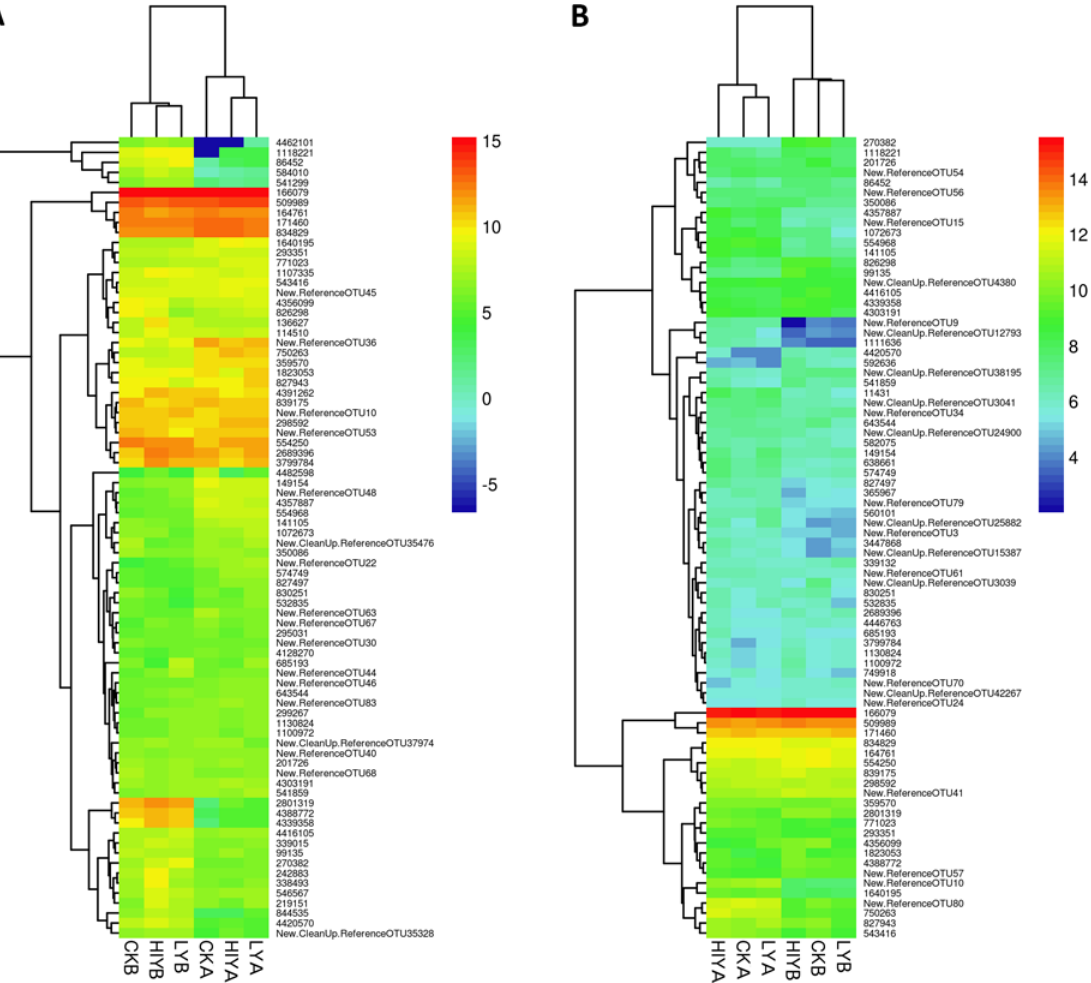
Fig 2. Heatmap showing the relative abundance of the top 80 OTUs of the microbiota. The figure describes autochthonous microbiota (A) and allochthonous microbiota (B) of Nile tilapia after 8 weeks of feeding with different diets. The microbial profiles of the 6 groups were clustered by complete linkage